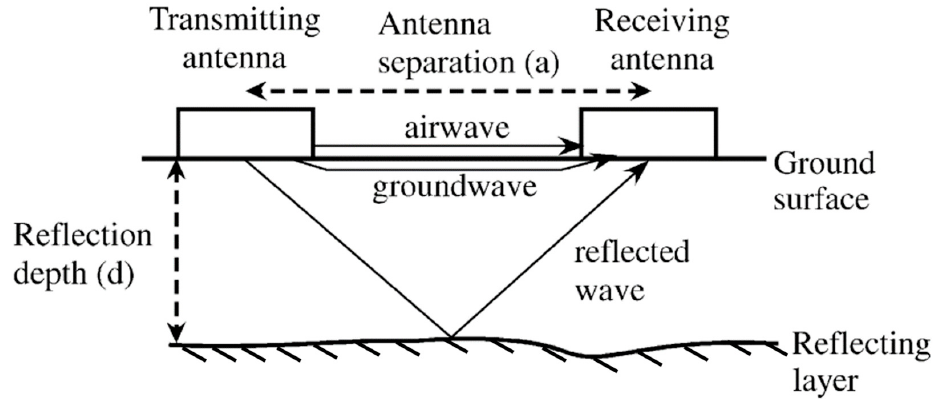
Figure 1. Structure and working principle of ground penetrating radar (GPR). Modified from [33].